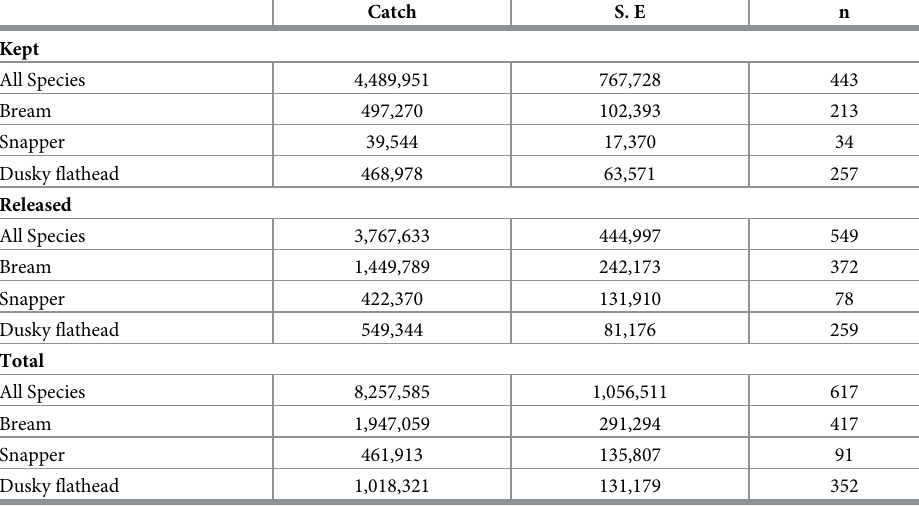
Table 1. The estimated kept, released and total number of all species/species groups, bream, snapper and dusky flathead caught within estuarine waters in NSW during 2013/14. Catch S. E n Kept All Species 4,489,951 443 Bream 213 Snapper 39,544 34 Dusky flathead 63,571 257 All Species 549 Bream Snapper 422,370 131,910 78 Dusky flathead 549,344 All Species 417 Snapper 461,913 91 Dusky flathead 1,018,321 131,179 352 n is the number of households surveyed to get the